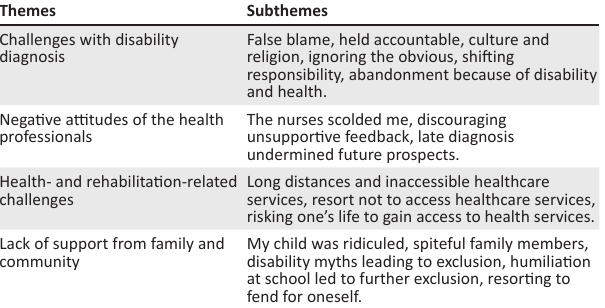
TABLE 1 : Presentation of four main themes with